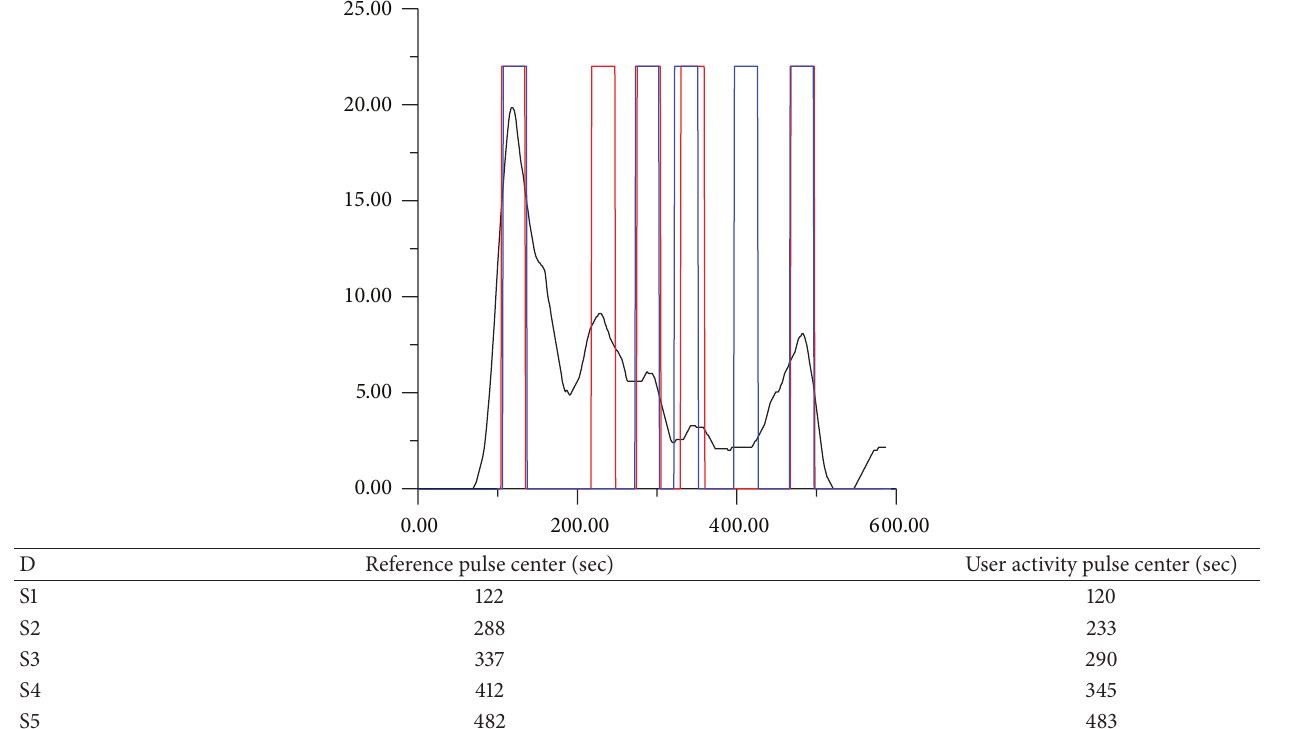
Table 5: Video D is a cooking (how-to) video (http://www.youtube.com/watch?v=LzkYvtqlT5I). The pulse width 𝐷 is 30 seconds and the smoothing window 𝑇 is 25 seconds. The pulse modeling is reported with respect to the center of each